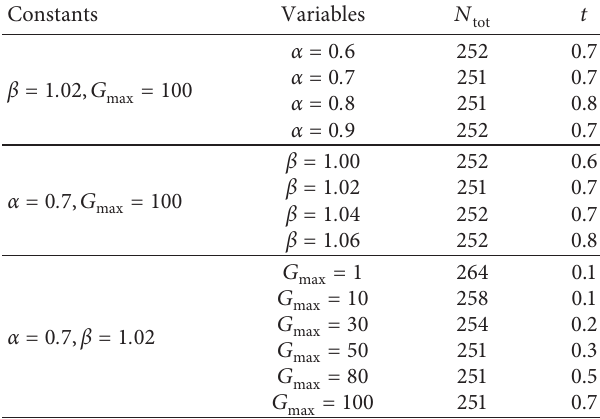
Table 1: Computational results of different parameter setting.